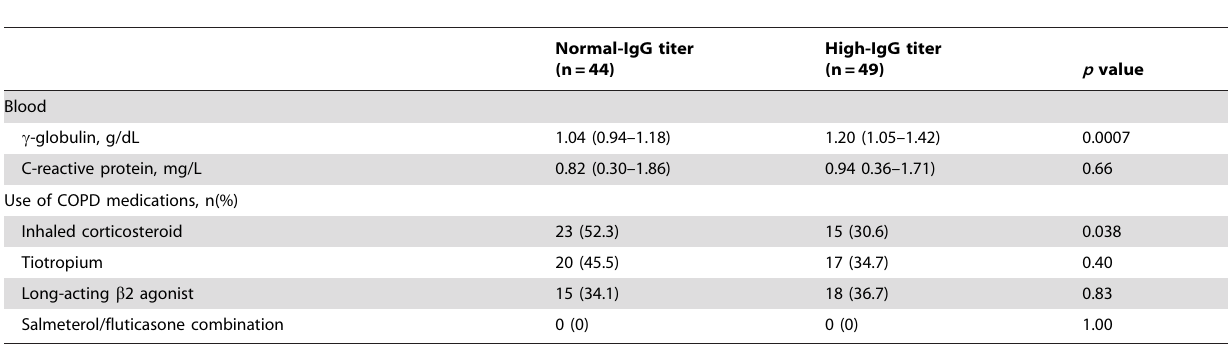
Table 3. Inflammatory markers in blood and use of COPD medication in patients between patients with normal and higher IgG titer against Porphyromonas gingivalis.